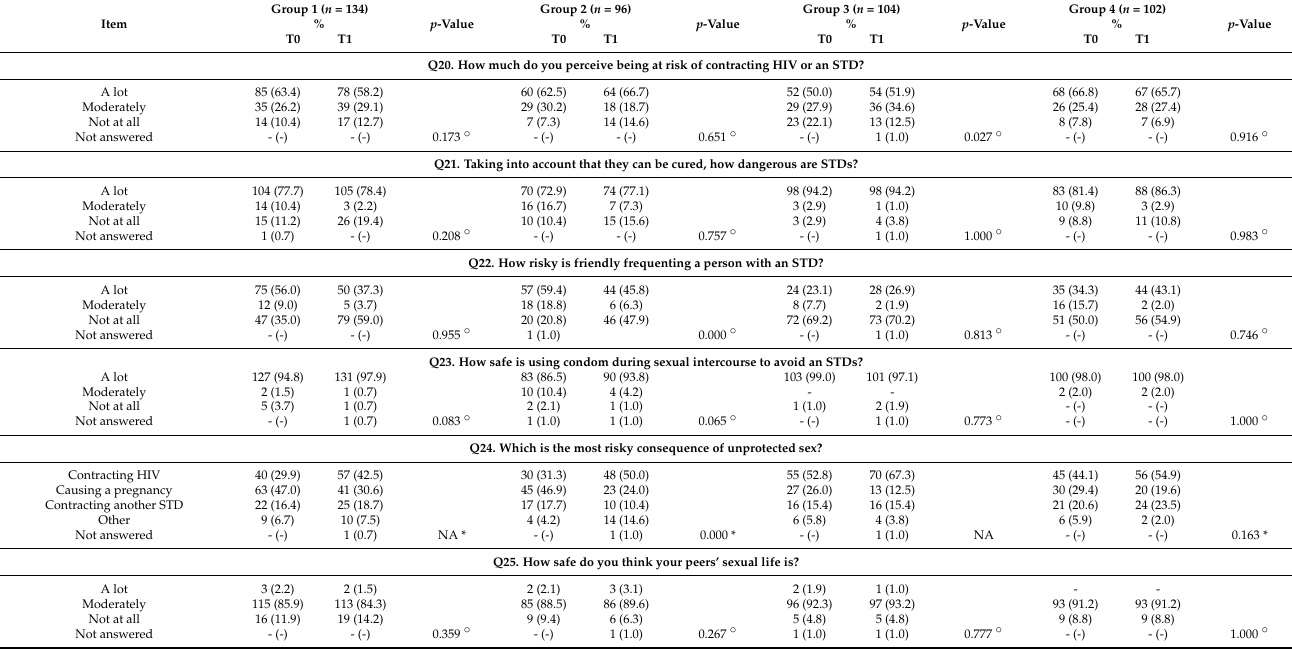
Table 6. Risk perception about HIV and STDs, before (T0) and after (T1) the educational